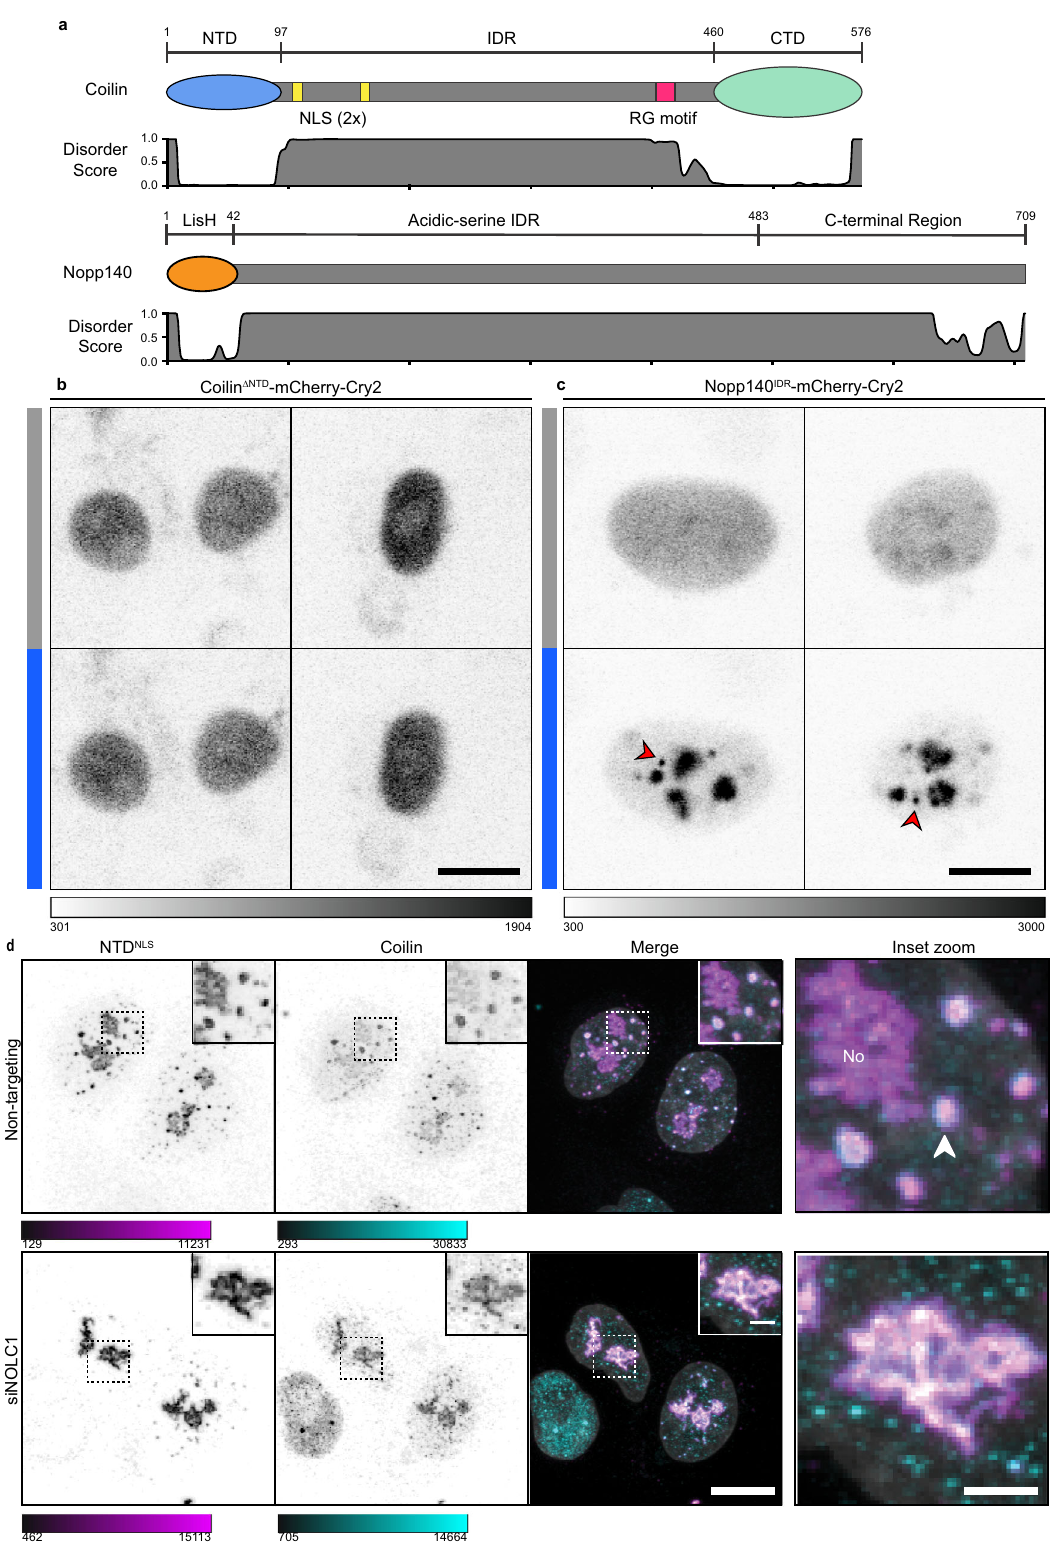
Fig. 3 | Nopp140formsinduciblecondensates and is requiredfor nuclearNTD puncta, suggesting a mechanism for Cajal body condensation. a Domain architectures of coilin and Nopp140 and predicted disorder score from RaptorX algorithm. b NIH-3T3cellsexpressingCoilin Δ NTD mCherry-Cry2construct.Bluebars indicate 3-minute light activation of the Cry2 domain. c NIH-3T3 cells expressing Nopp140 IDR mCherry-Cry2 construct. Red arrowheads indicate non-nucleolar bodies formed by blue light induction. d HeLa cells transfected with siRNA, non-